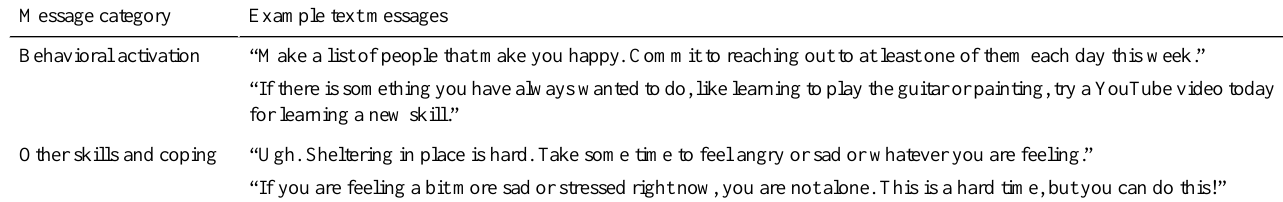
Table 2. Examples of StayWell at Home text messages.